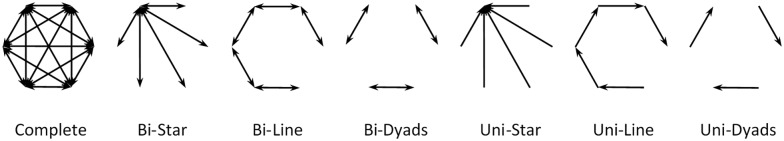
Topology of seven auditory networks tested in the experiment.Each arrow represents a source node being able to hear a destination node. Networks are sorted from left to right by decreasing density (see SI Appendix).